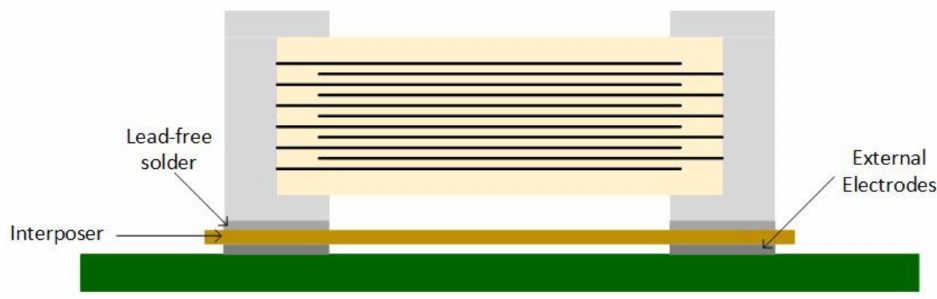
Figure 5. Interposer